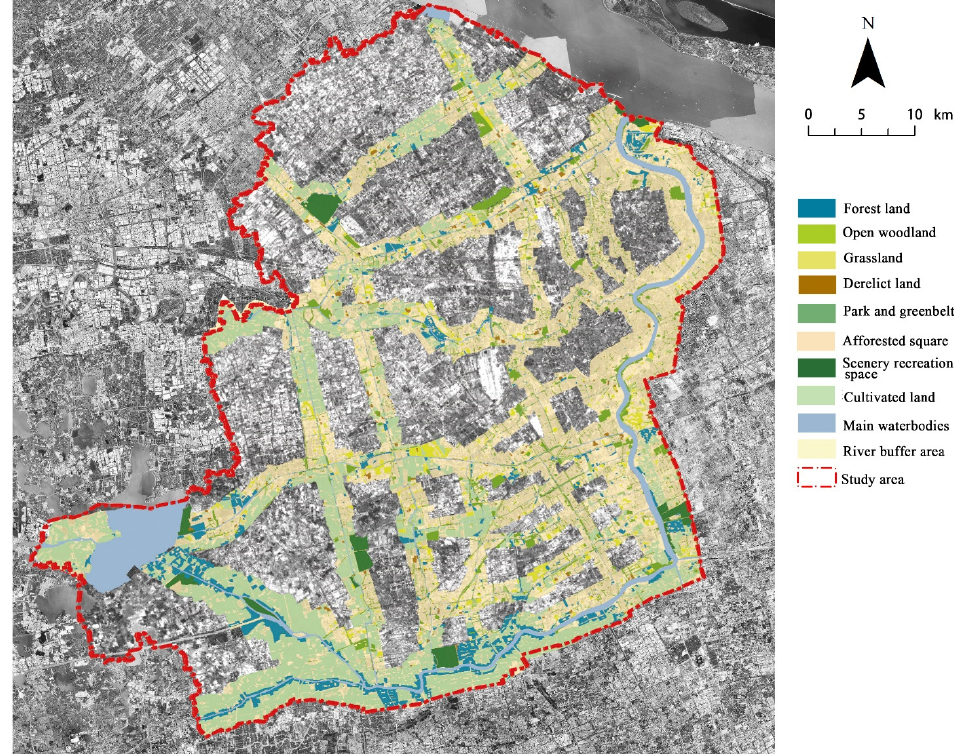
Figure 5. Distribution of greenspace types in the study area based on land-use classification. Table 2. Multidimensional spatial variables to describe riverfront greenspaces morphology based on the CI.